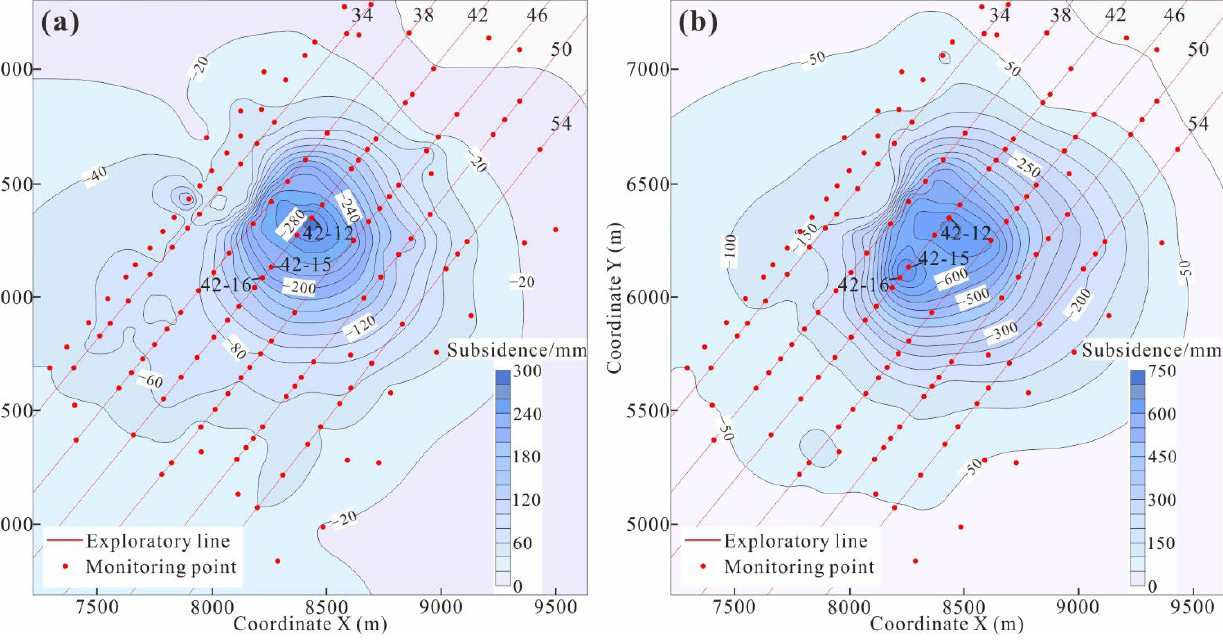
Figure 3. Contour map of surface subsidence (unit: mm). ( a ) Surface subsidence contour map from May 2005 to November 2010; ( b ) Surface subsidence contour map from May 2005 to November 2019.